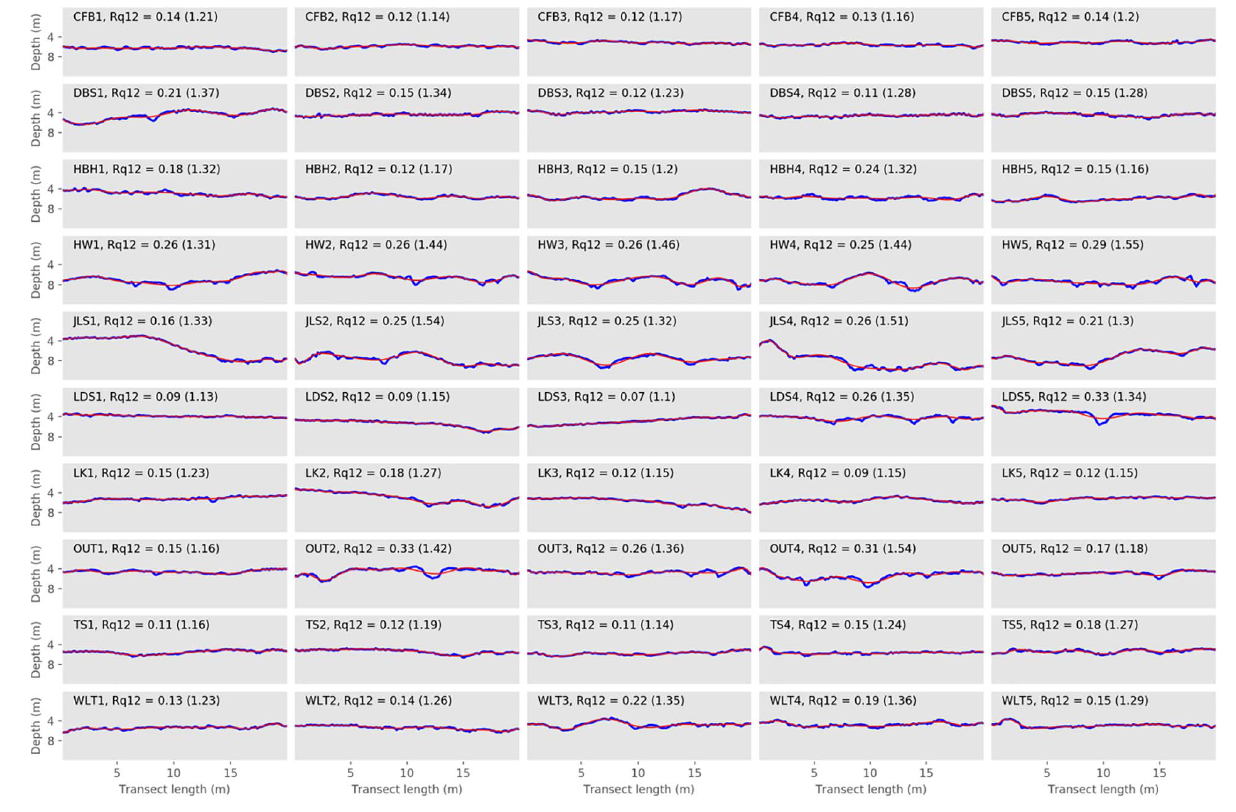
FIGURE 5 | Depth profiles of the surveyed transects along with their twelfth order of polynomial. Elevation profiles (blue lines) for each transect from the 10 surveyed sites in 2015. Red lines represent the twelfth order polynomials. Chain index results are reported in